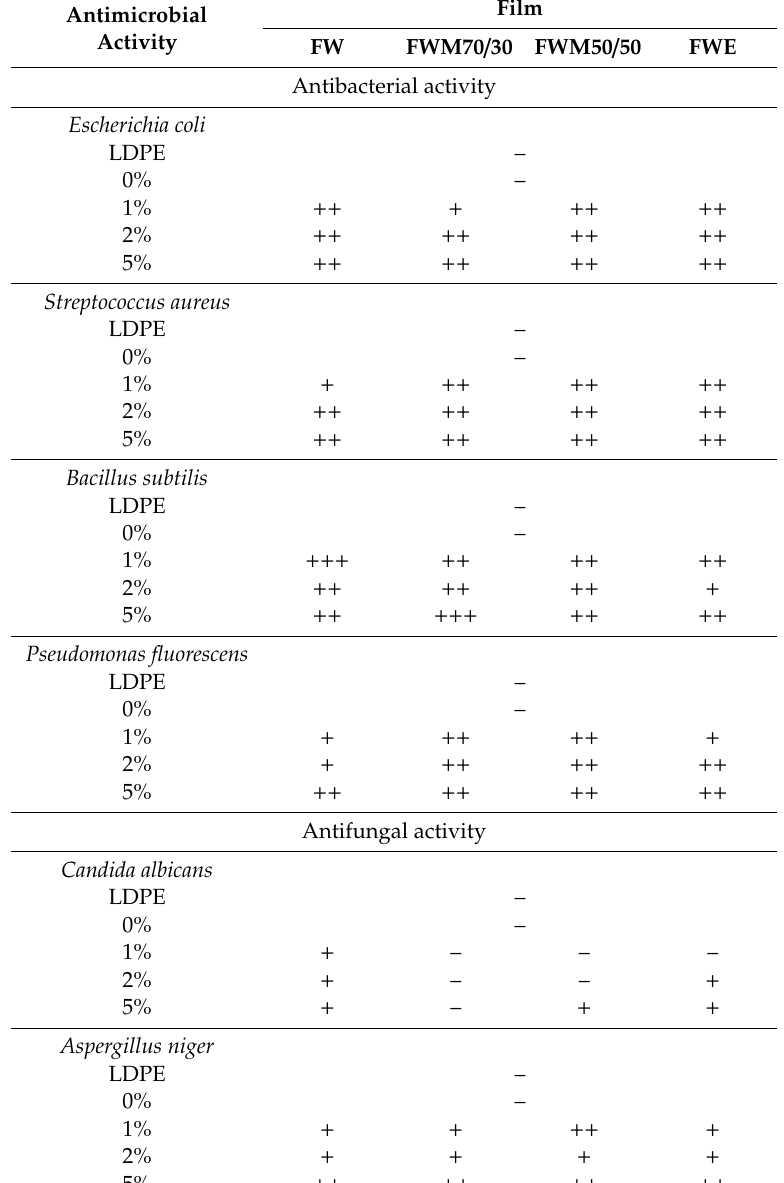
Table 10. Antimicrobial properties of starch films with chicory root extracts and phytic